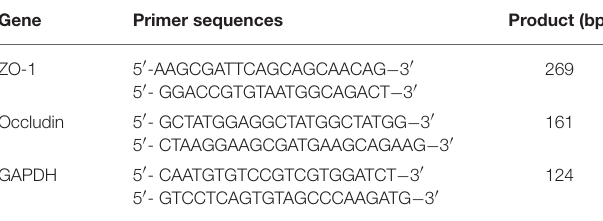
TABLE 1 | Oligonucleotide sequences used for real-time RT-PCR.